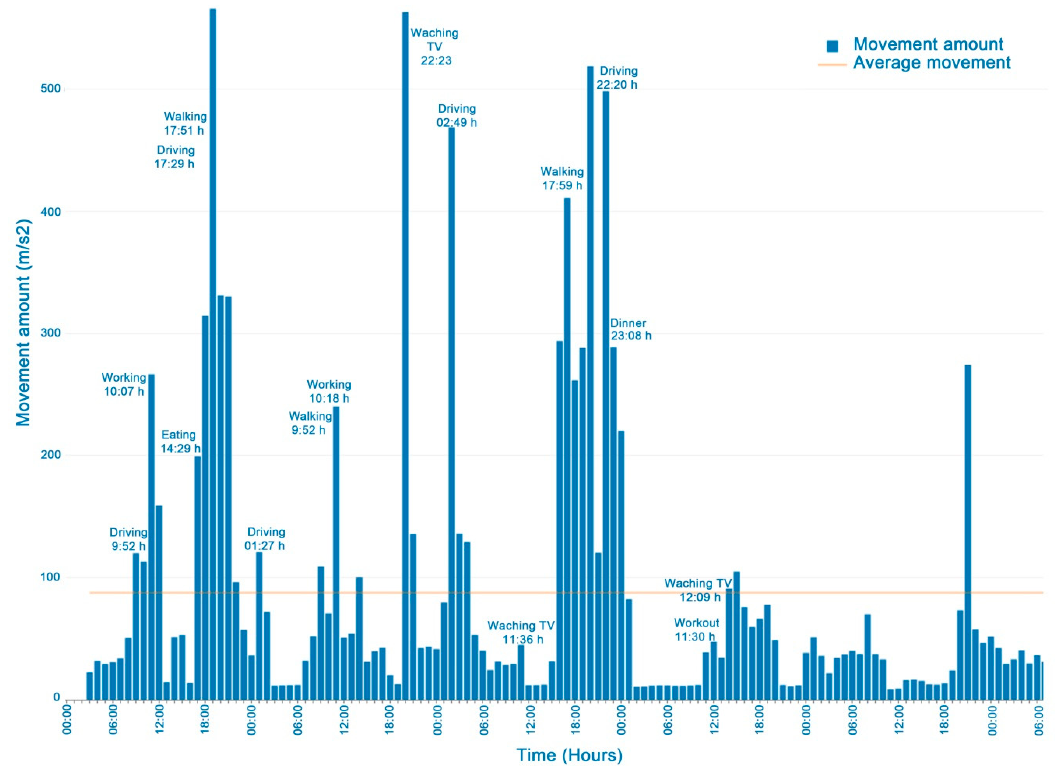
Figure 3. Amount of movement per hour and event tags in a five day HDRS monitoring period.